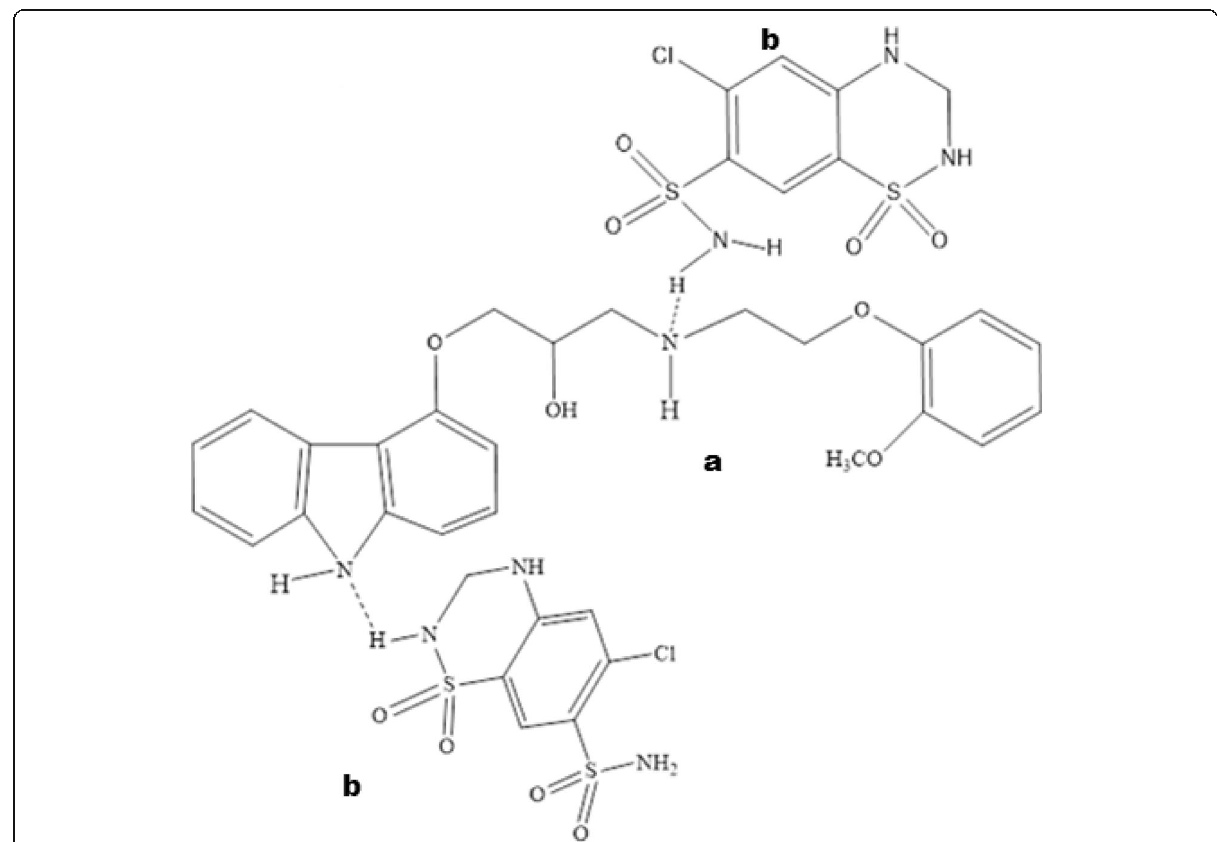
Fig. 3 The possible intermolecular interactions between CAR-HCT a CAR and b HCT